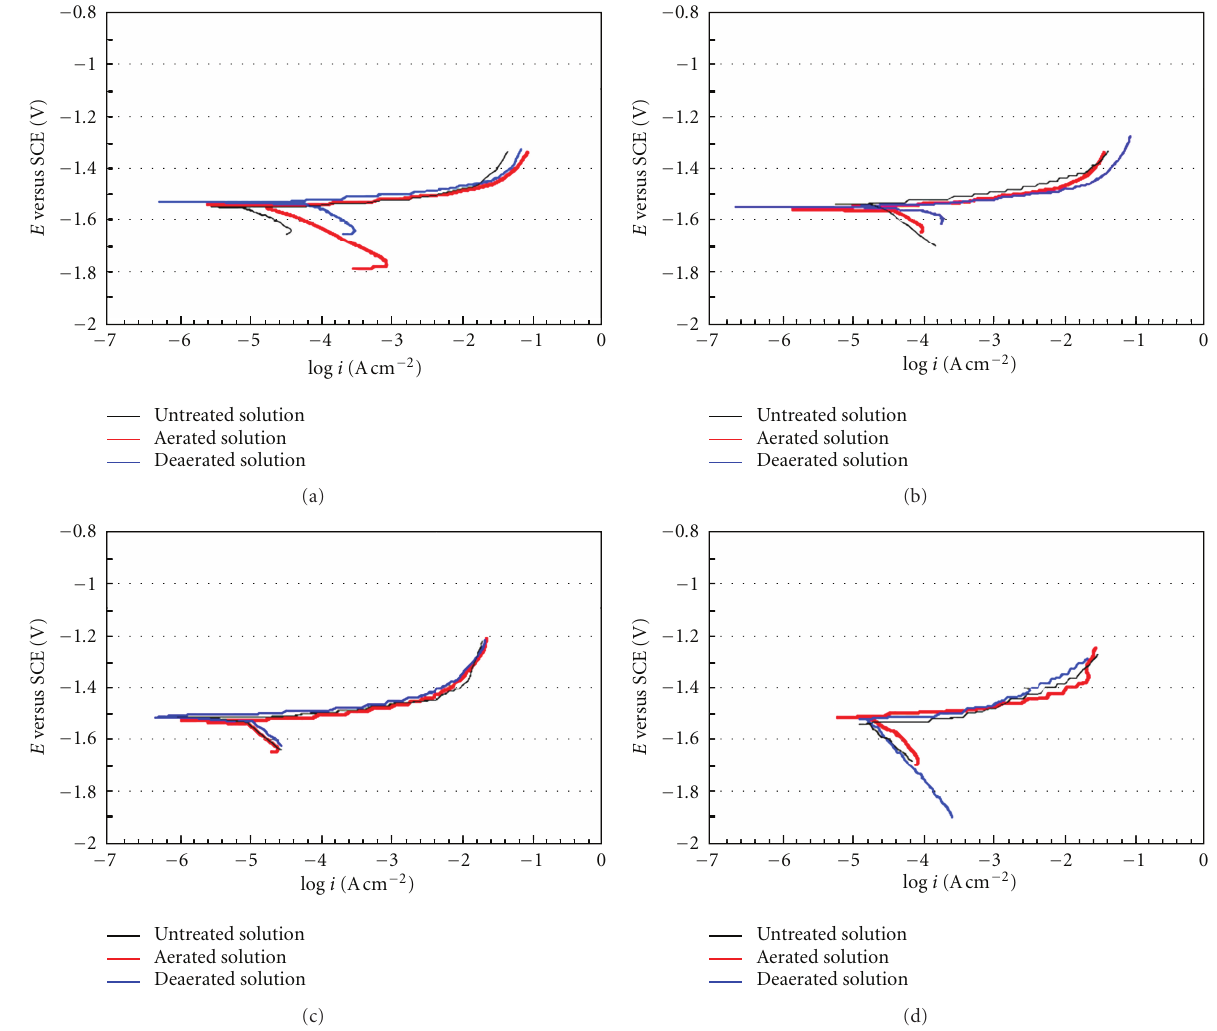
Figure 3: Potentiodynamic curves at a scan rate of 0.1mV · s − 1 for (a) AZ91D, (b) AZ91E, (c) ZA104, and (d) ZAC10403 in untreated, aerated, and deaerated 5% NaCl solution saturated with Mg(OH) 2 at pH 9 and 25 ◦